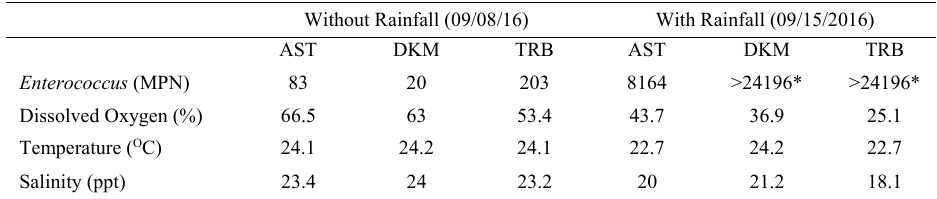
Table 1: Levels of Enterococcus, dissolved oxygen, temperature and salinity were measured at each site during a 2-day period without and with